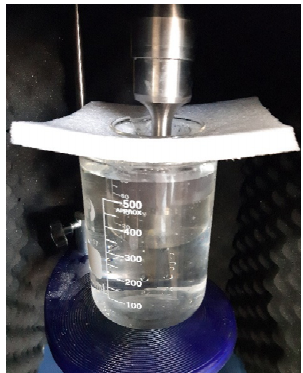
Figure 2. Water cooling setup of nanocomposite preparation using a sonicator. Table 1. Summary of ultrasonic parameters employed.